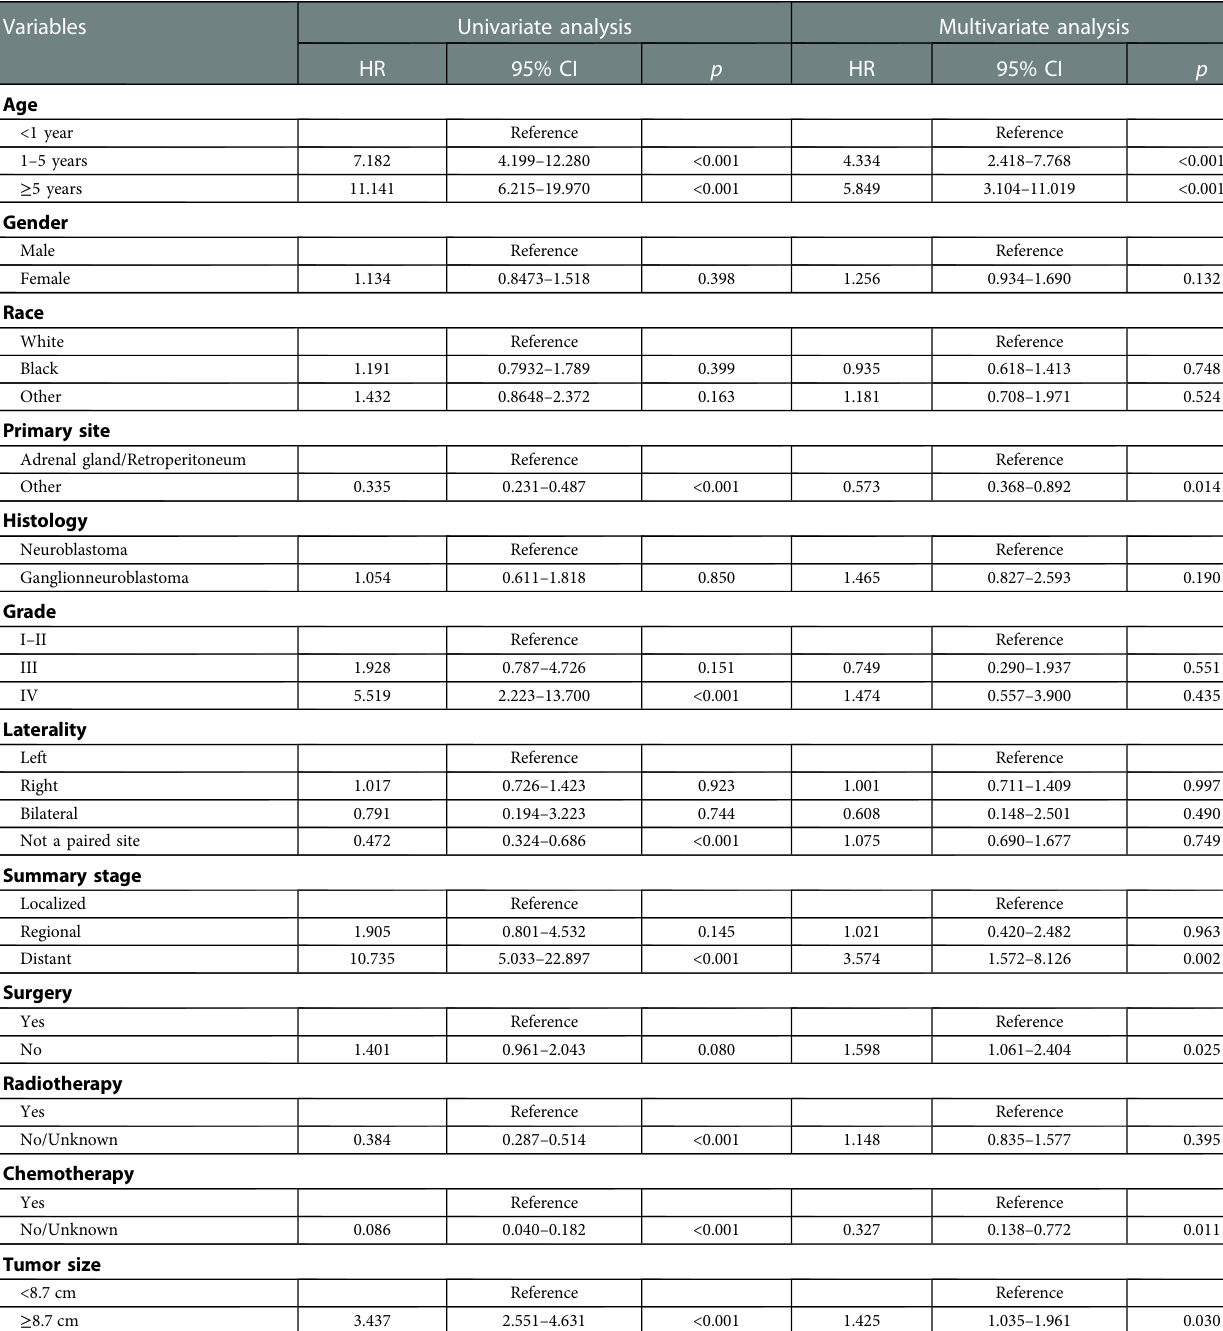
TABLE 2 Univariate and multivariate Cox regression analysis for cancer-speci fi c survival in patients with neuroblastoma.